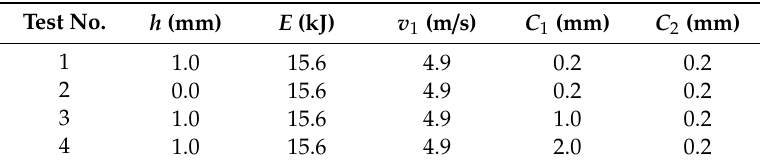
Table 1. The processing parameters in the shearing tests.